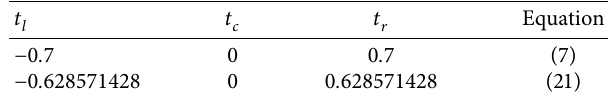
Figure 1: Te best generalized fuzzy quantity for w � 10, solid curve: u ; dashed curve: equation (7); dotted curve: equation (21). Table 2: Results of Example